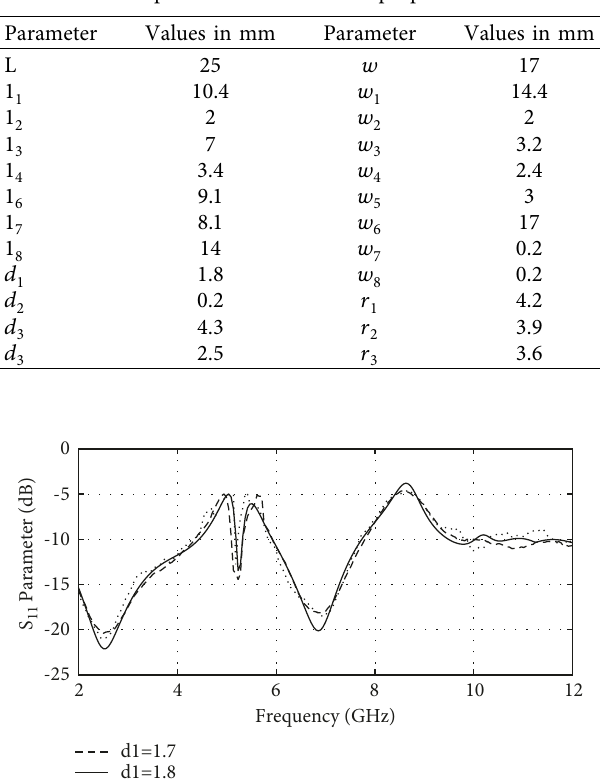
Table 1: Optimized dimensions of proposed antenna.